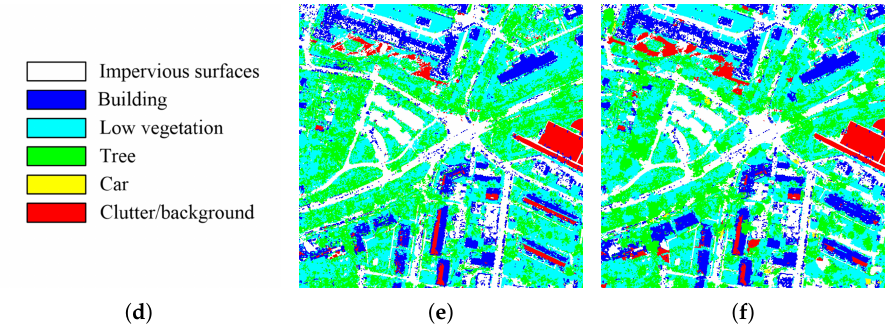
Figure 9. Classification maps generated from Potsdam-3_10: ( a ) ground truth; ( b ) XGB + BT; ( c ) XGB + BT + SNSSL; ( d ) class label; ( e ) SVM + MCLU; ( f ) SVM + MCLU +